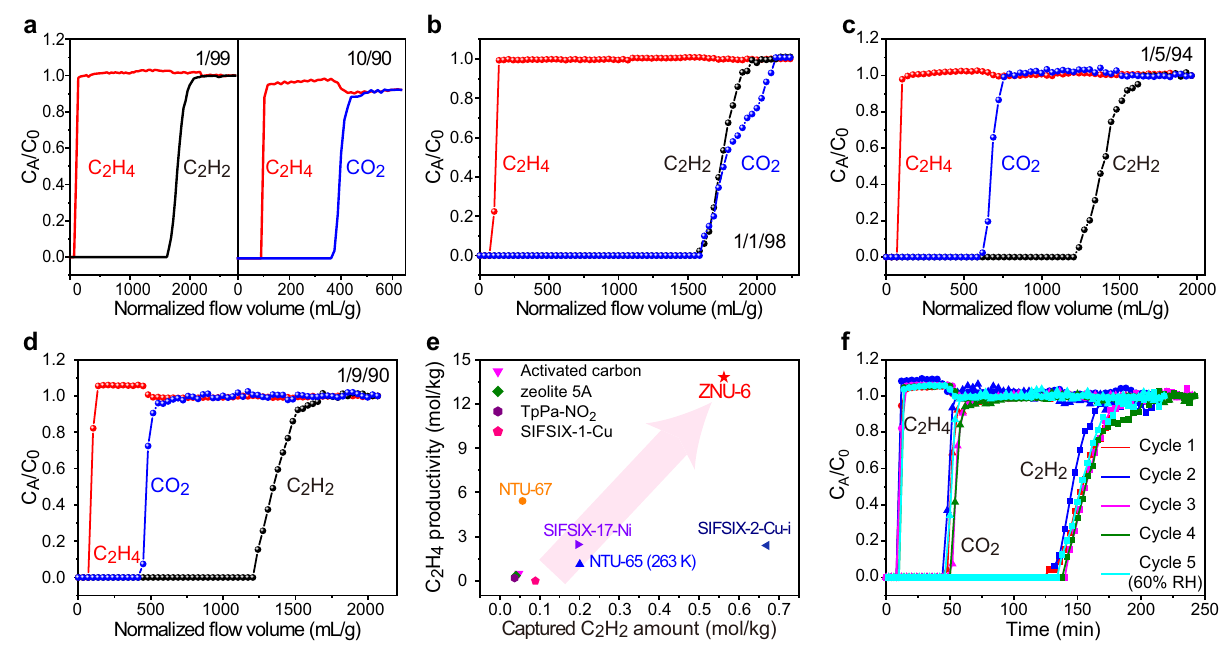
Fig. 5 | C 2 H 4 puri fi cation. Experimental breakthrough curves of ZNU-6 for binary mixture a C 2 H 2 /C 2 H 4 (1/99) and CO 2 /C 2 H 4 (10/90) at 298K. Experimental break- through curves of ZNU-6 for ternary mixture b C 2 H 2 /CO 2 /C 2 H 4 (1/1/98), c C 2 H 2 / CO 2 /C 2 H 4 (1/5/94), and d C 2 H 2 /CO 2 /C 2 H 4 (1/9/90). e Comparison of the